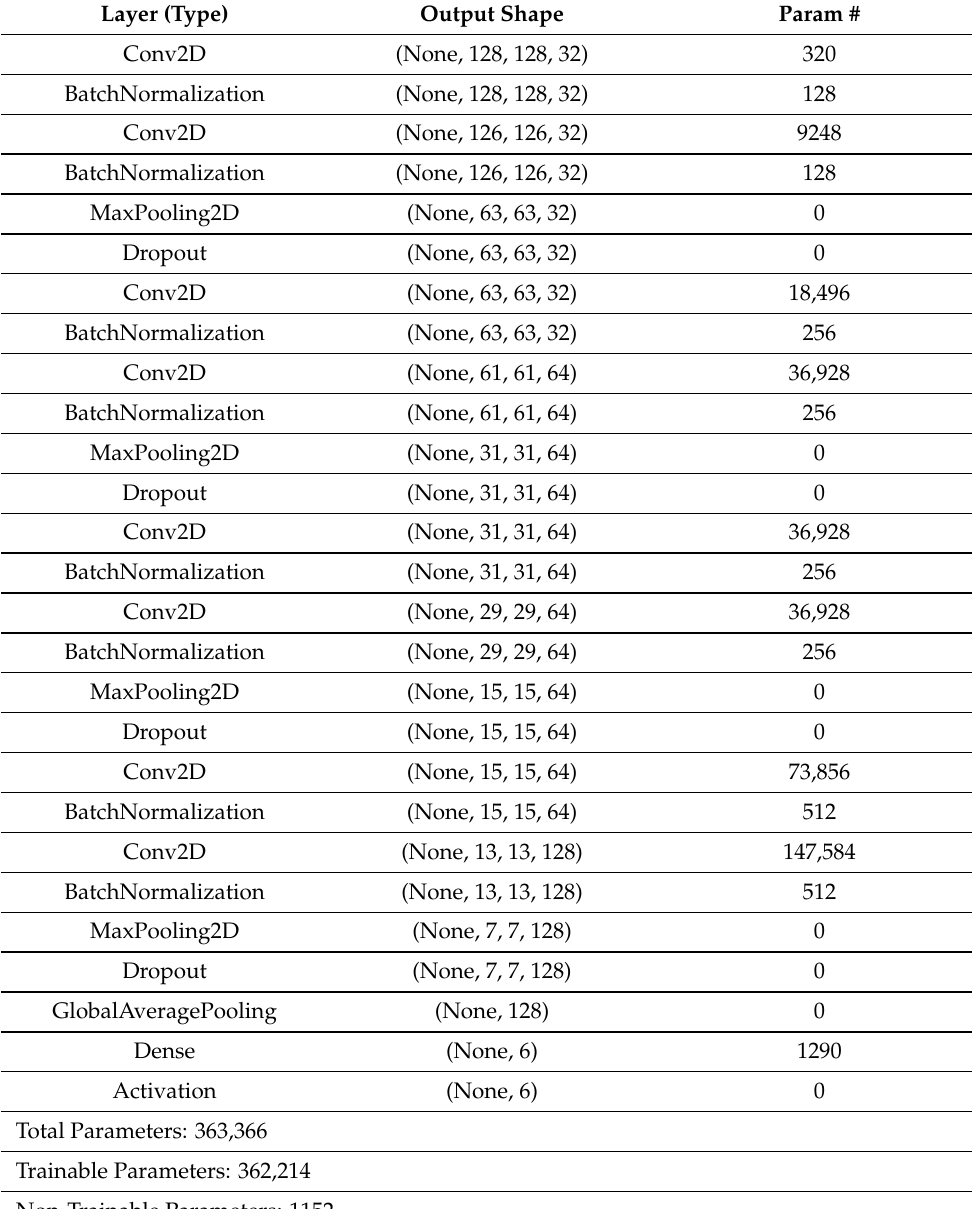
Table 4. FDC-3 Model